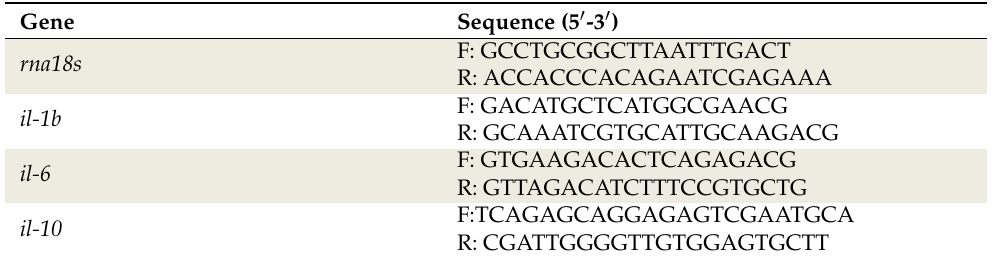
Table 1. Primes used for the amplification of zebrafish